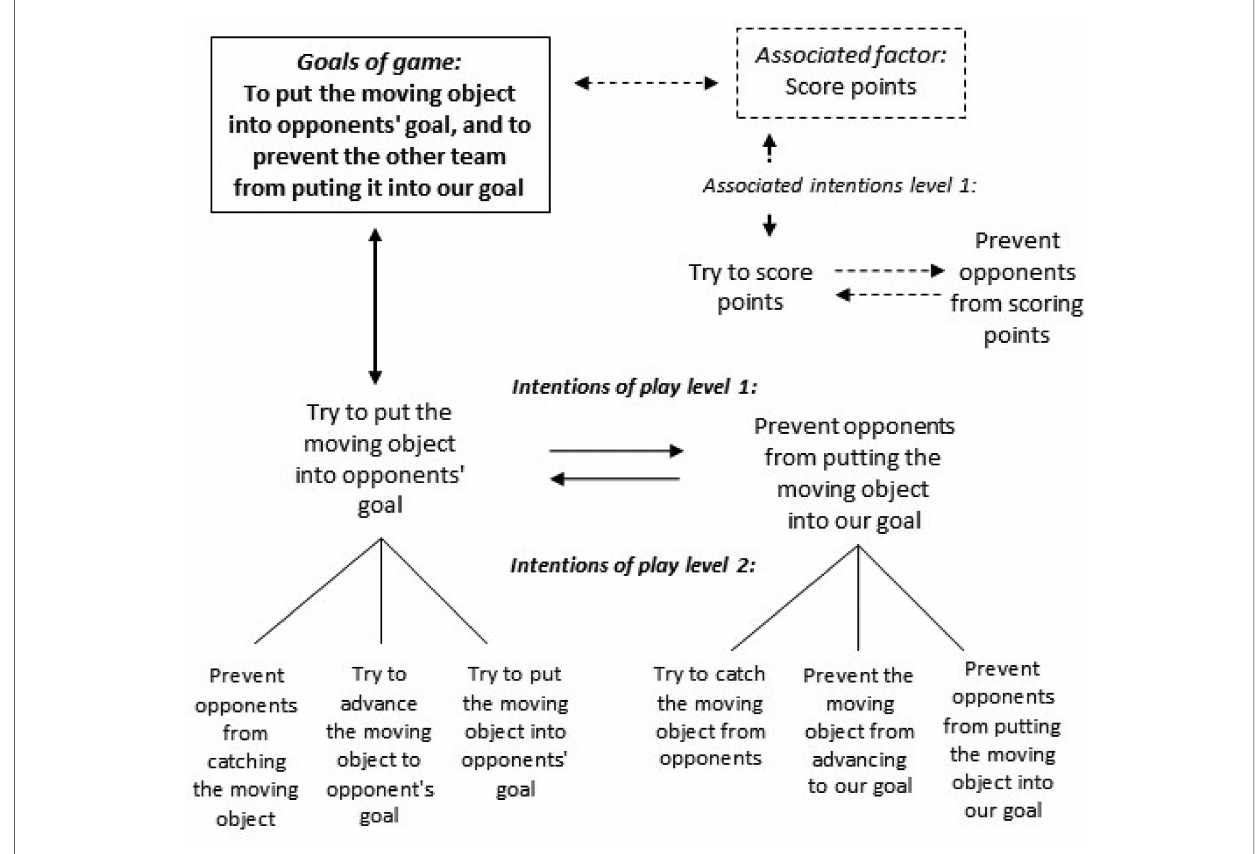
FIGURE 3 Network model of intentions of play of invasion games (according to the principles of play proposed by Bayer